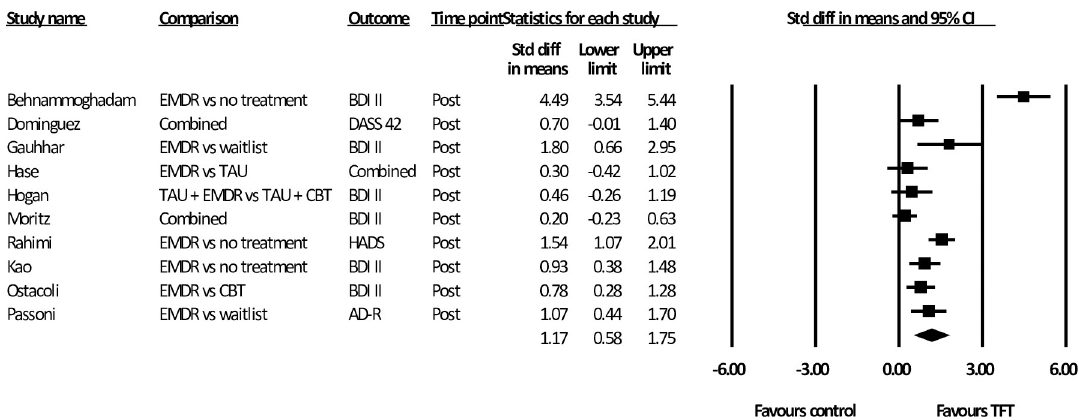
Fig 2. Standardised effect sizes of trauma-focused treatments for depression compared to control conditions at post-test.